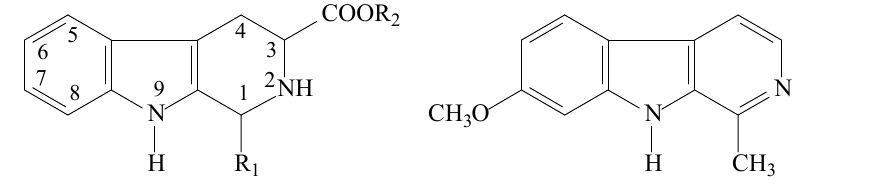
Table 1. Structure of tetrahydro- β -carboline compounds.